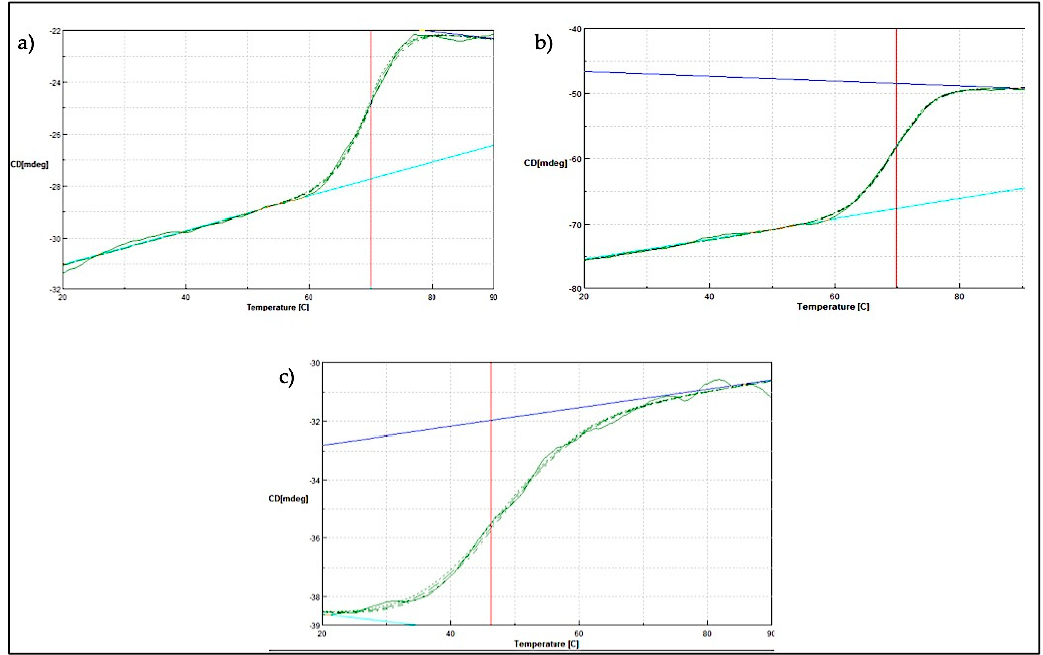
Figure 8. Thermal denaturation profile of SK72 DNA polymerase and its variants. ( a ) SK72, ( b ) SK72-Exo, ( c ) SK72-Exo2. Vertical line (red) indicating the melting point value of each variant when tested from temperatures ranging from 20 to 90 °C.